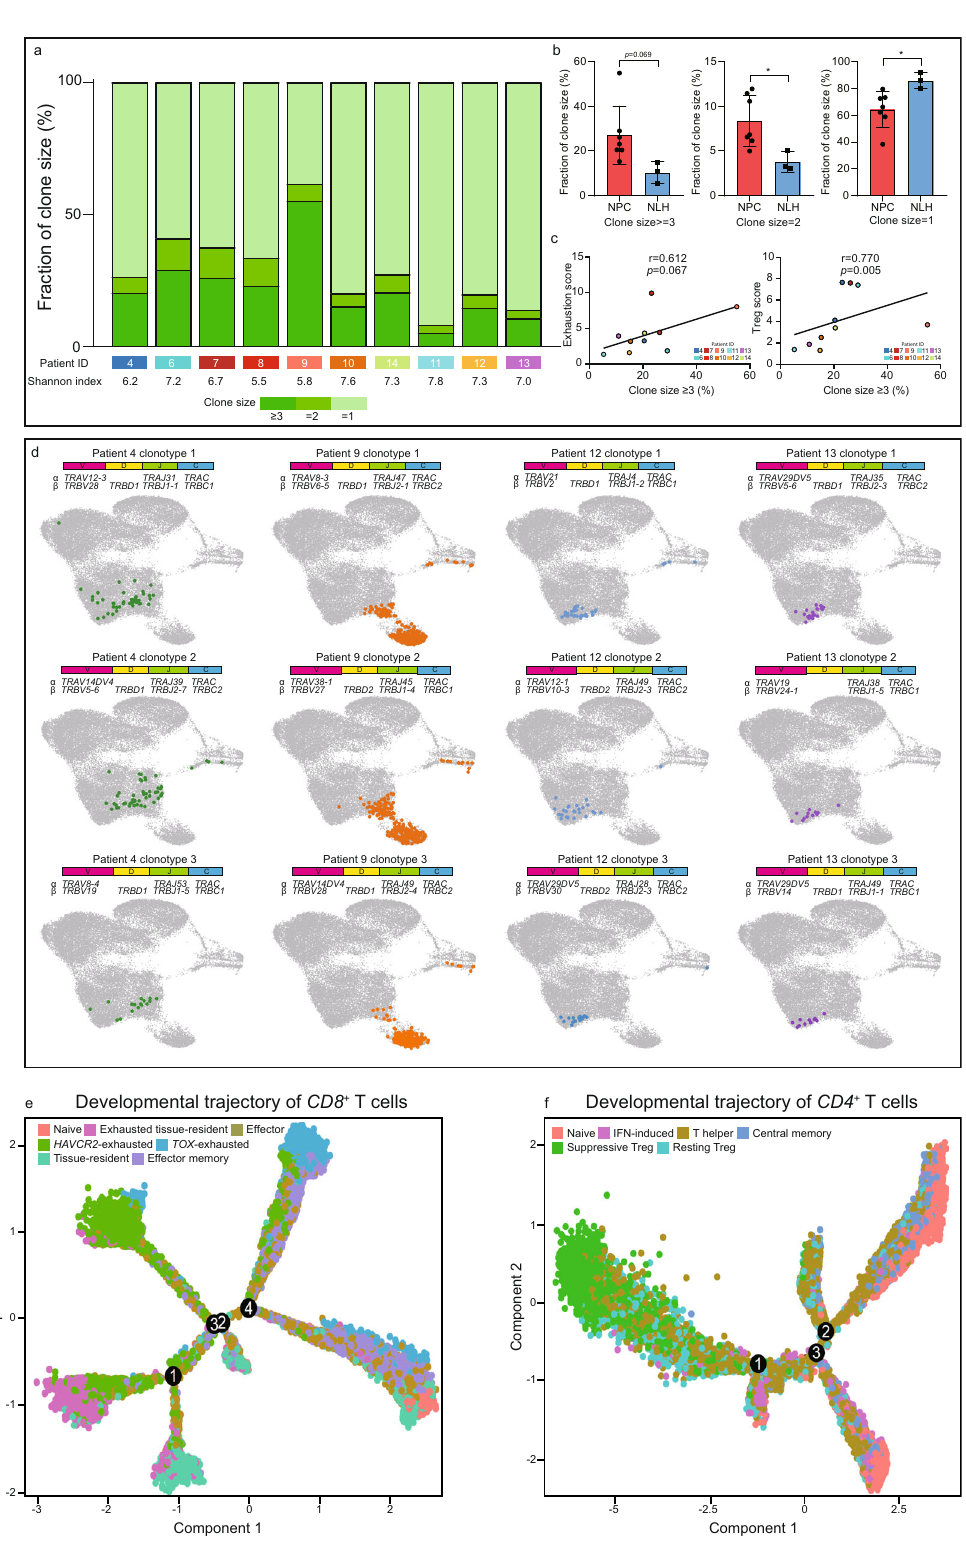
Fig. 5 Single-cell V(D)J sequencing reveals the clonal expansion and activation-to-exhaustion transition in exhausted and immunosuppressive T cell subtypes. a Distribution of T cell clones by size, with different Shannon index showing the clonal diversity for each patient. b The relative abundance of different clone sizes in the NPC-derived ( n = 7 biologically independent samples) and NLH-derived ( n = 3 biologically independent samples) T cells. Each dot represents one patient. The two-sided Student ’ s t test was used to determine the statistical signi fi cance, p values ≤ 0.05 were represented as *, ≤ 0.01 as **, ≤ 0.001 as ***, ≤ 0.0001 as ****. Data are presented as mean values ± SD. c The Spearman ’ s correlation between the calculated exhaustion score/ Treg score and the fraction of clones with ≥ 3 cells in patients. Source data are provided as a Source Data fi le. d UMAP plot of the top three largest clones in patients 4, 9 (NPC) and 12, 13 (NLH), with their associated clonotypes. ( e and f ) The developmental trajectory of CD8 + and CD4 + T cells, colored-coded by the associated cell subpopulations and numbered by different developmental branches. NATURE COMMUNICATIONS| (2021) 12:1540